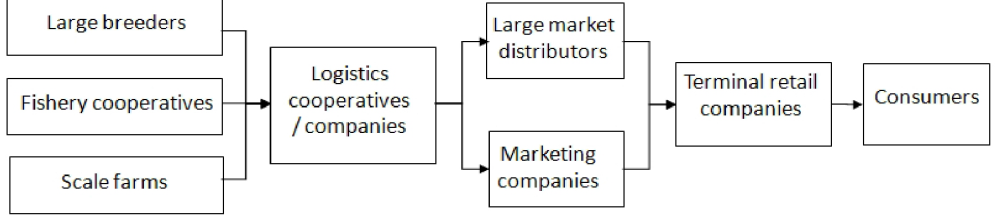
Figure 4. Subjects relationship of Semi-compact Organization